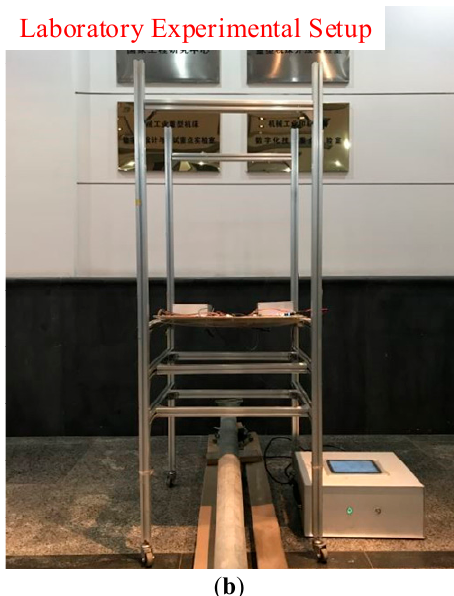
Figure 6. Error analysis under different SNR. ( a ) The values of RMSE; ( b ) the values of 2-Norm.